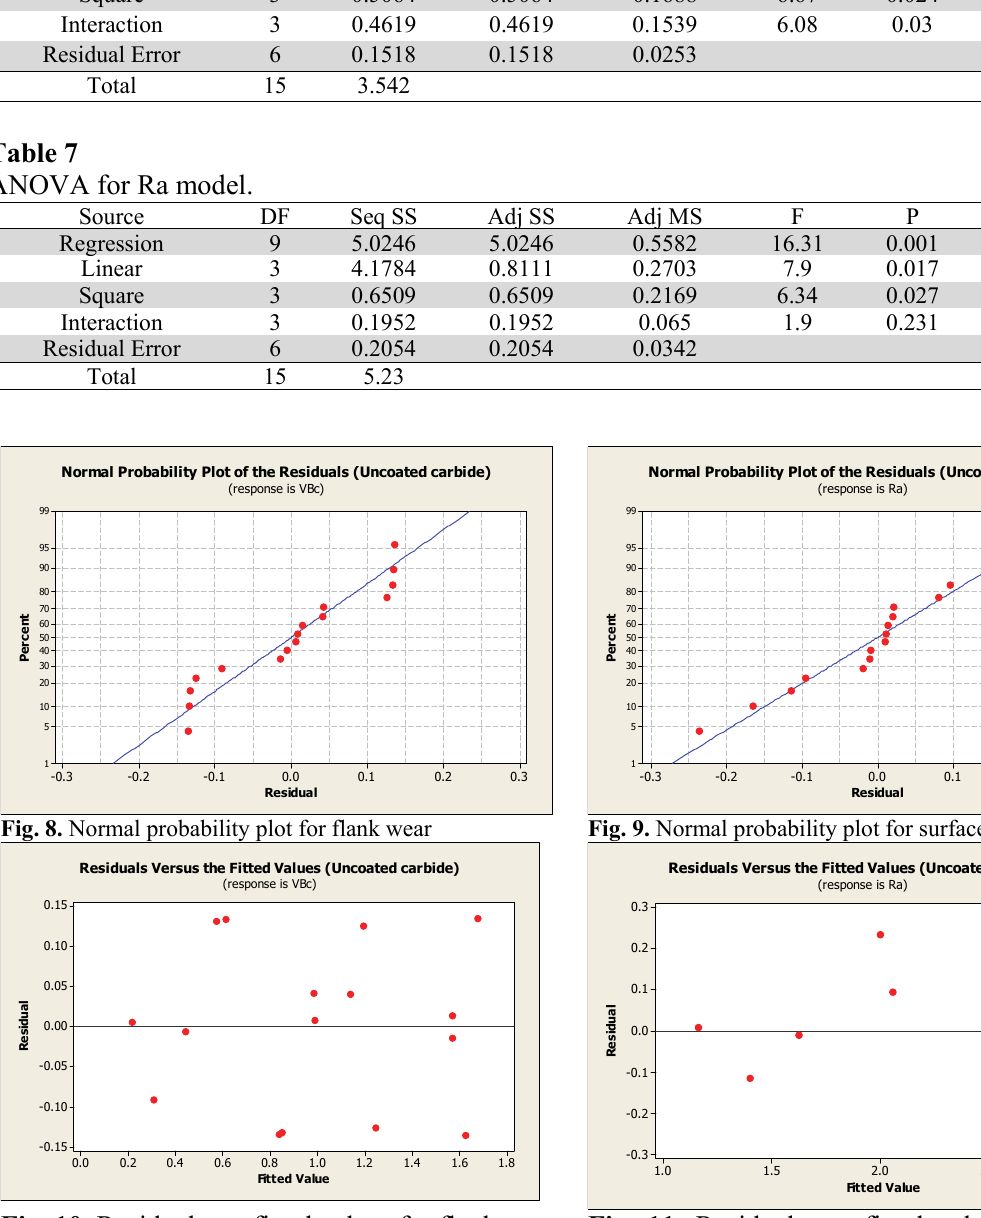
Fig. 10. Residuals vs. fitted values for flank wear Fig. 11. Residuals vs. fitted values for surface